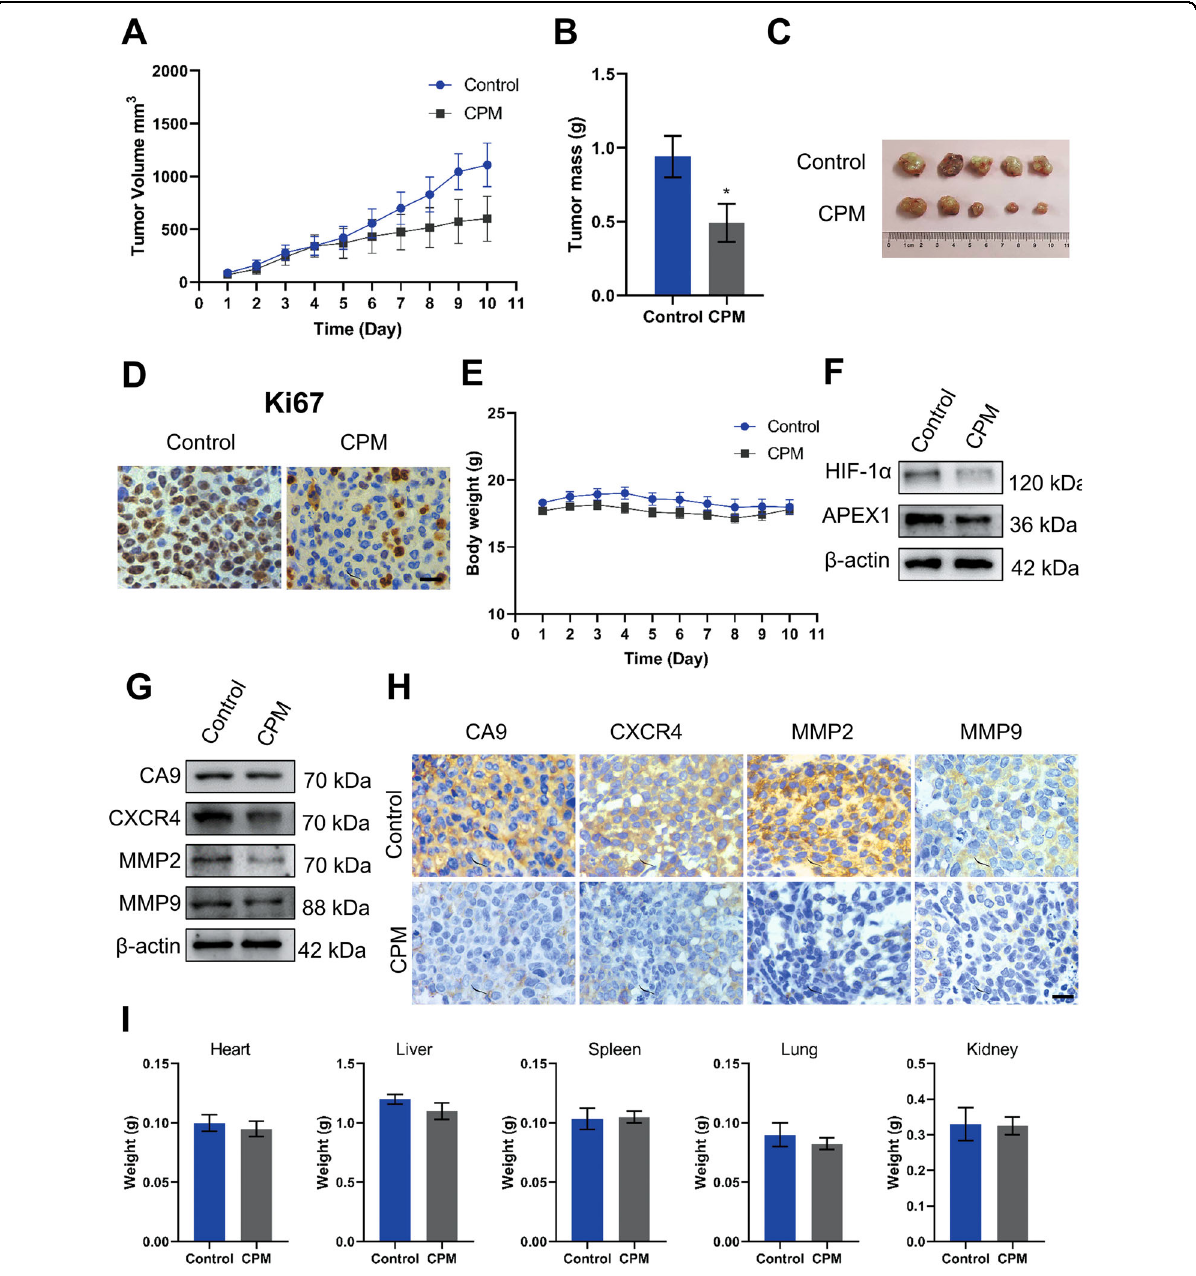
Fig. 7 CPM inhibited growth and proliferation of H460 LC xenograft tumor model. A Xenograft tumor volume was measured in the control group and the CPM-treated group during the 10-day experiment. B Xenografts tumor mass was measured of control and CPM-treated group. C Image of tumors from the control group and the CPM-treated group in a xenograft tumor model. D Analyzing the tumor tissue proliferation, both control and CPM-treated tissue were stained with proliferation marker Ki67. Scale bar, 50 μ m. E Xenograft animals body weight was measured in the control group and the CPM-treated group during the 10-day experiment. F Western blot analysis of APEX1 and HIF-1 α in control group tumor tissue and CPM-treated tumor of xenograft tumor. G Western blotting analysis of protein expression of CA9, CXCR4, MMP2, and MMP9 in control group tumor tissue and CPM-treated tumor of xenograft tumor. H Immunohistochemical staining of CA9, CXCR4, MMP2, and MMP9 in the section of the control group and the CPM-treated group of xenografts nude mice. I Weight of the vital organs heart, liver, spleen, lung, and kidney of animals of the control group and the CPM-treated group. Data were expressed as mean ± SEM ( n = 5). * P < 0.05, compared to control groups.